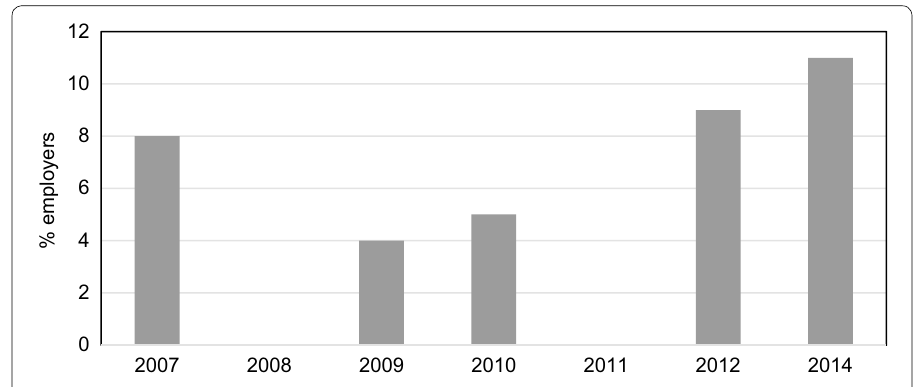
Fig. 1 Percentage of employers with an apprentice in England (Source: Employers Skill Surveys 2007 and 2009, Employer Perspectives Surveys 2010, 2012 and